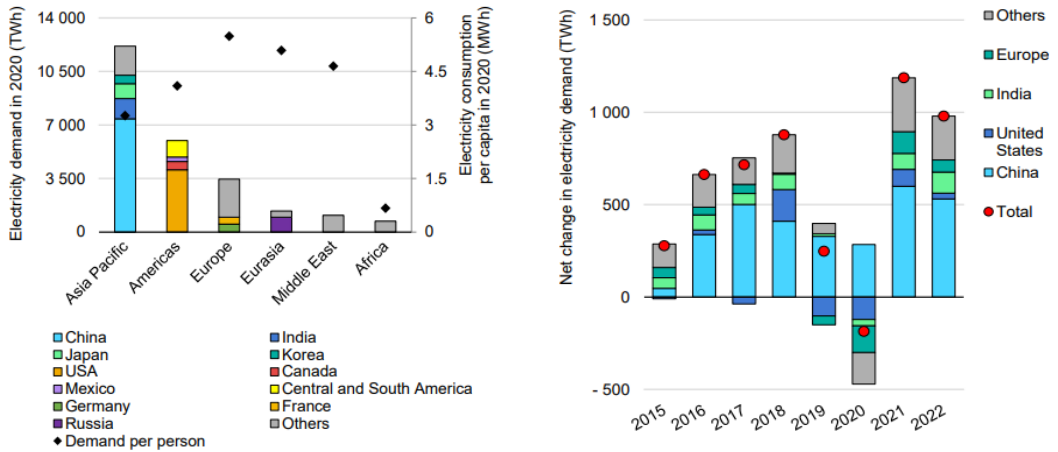
Figure 4. Changes in electricity demand by region in 2020–2022 [57]. Source: IEA (2021) Electricity Market Report - July 2021. All rights reserved.